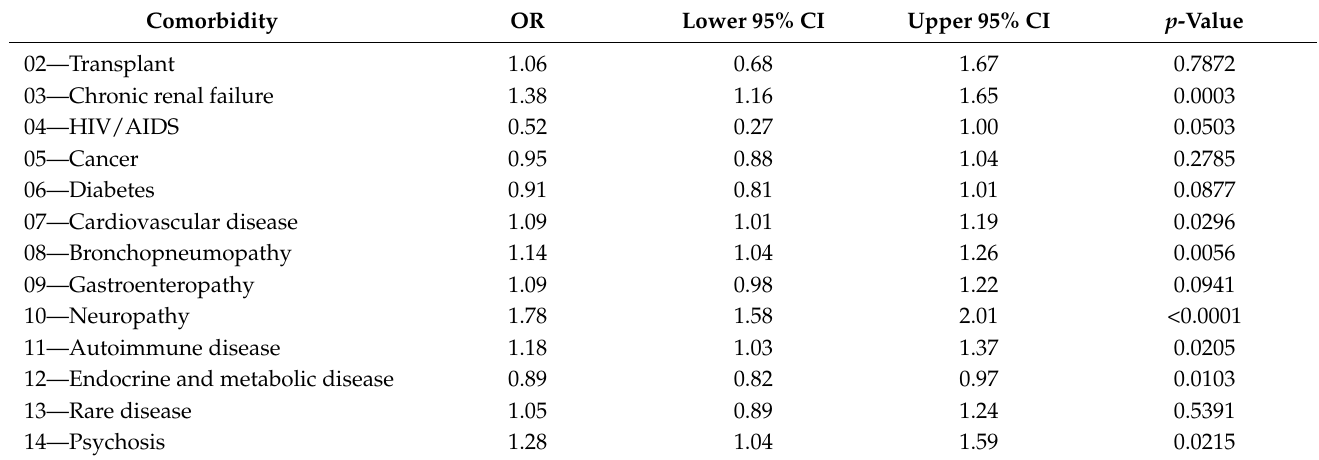
Table 3. Comorbidities implicated in reinfected SARS-CoV-2 patients from September 2021 to May 2022. Comorbidity